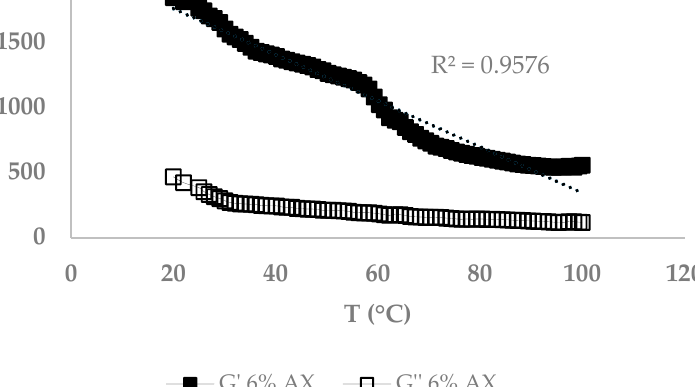
Figure 8. Melting point of gelatin gel (6%).